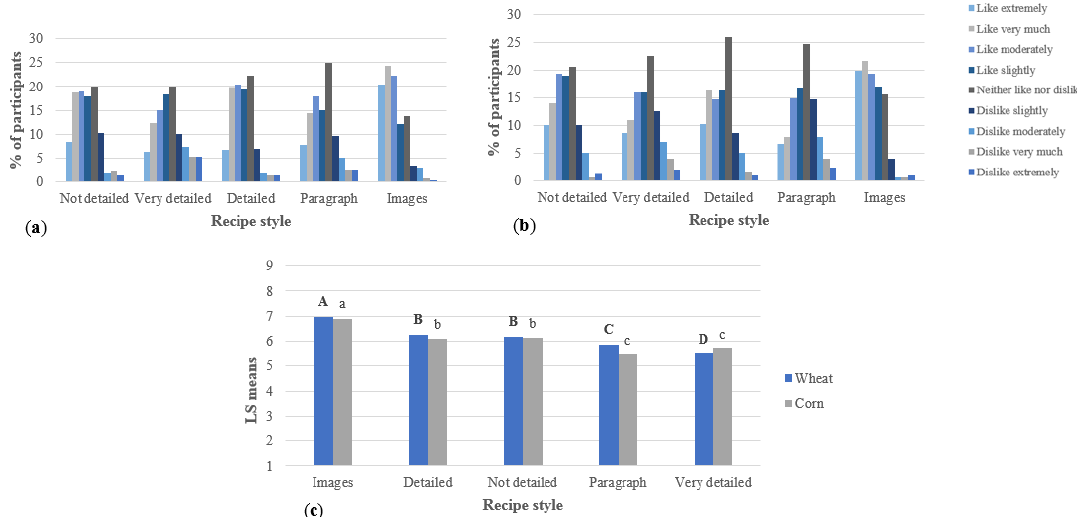
Figure 4. Likeability of the recipes presented to respondents (per study, n = 300), including ( a ) wheat study, ( b ) corn study, and ( c ) ANOVA. For the ANOVA, statistical comparisons are within wheat and corn recipes: bold, uppercase letters represent the wheat recipes; not bold, lowercase letters represent the corn recipes. Different letters among studies represent significantly different means ( p < 0.05).